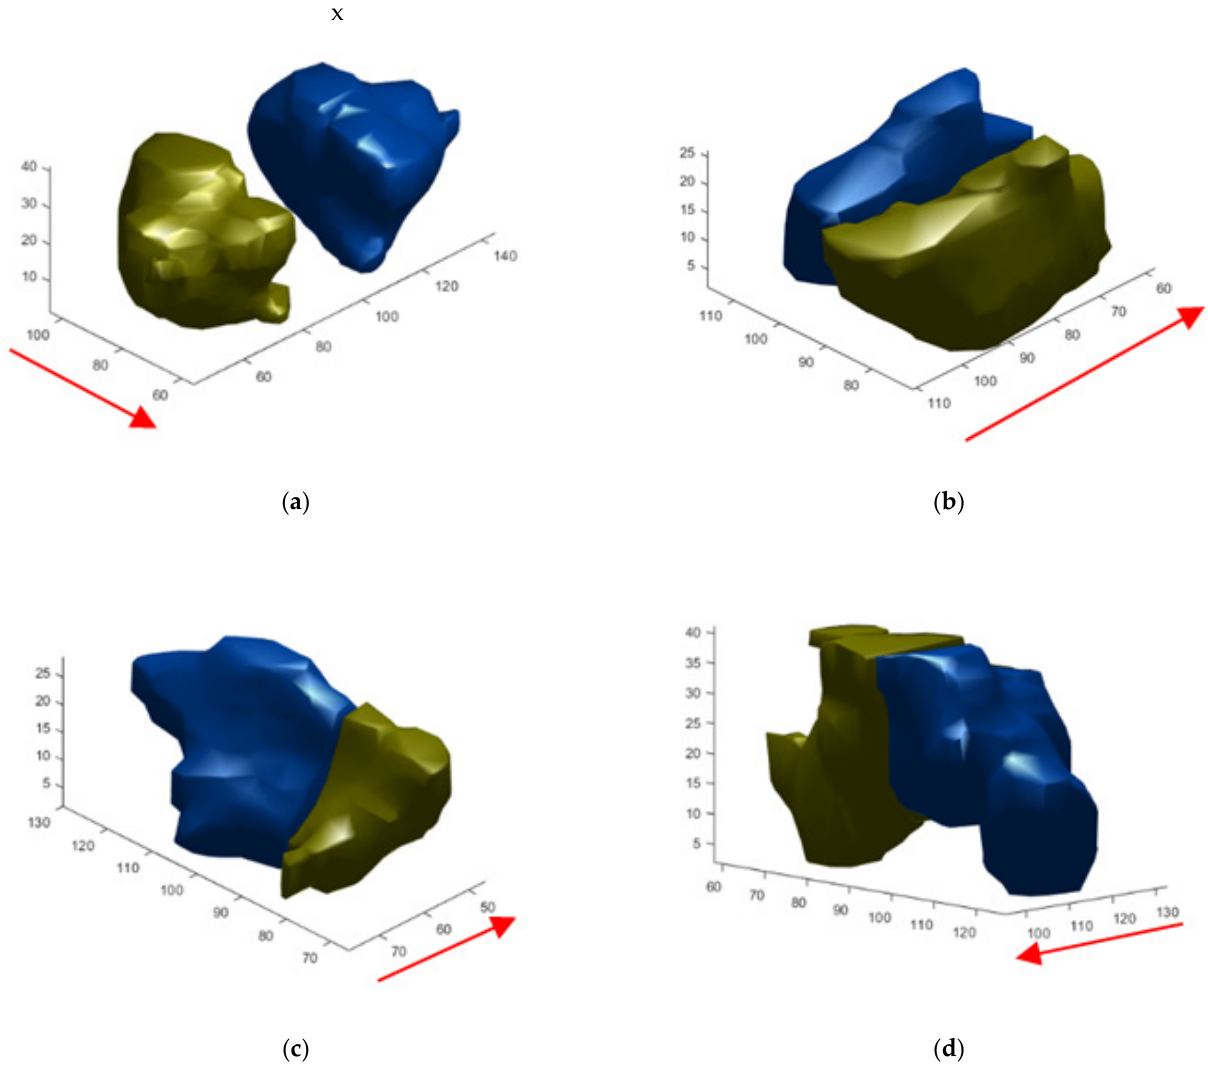
Figure 24. Resulting images of Marching Cube 3D reconstruction of paranasal sinuses (unit: